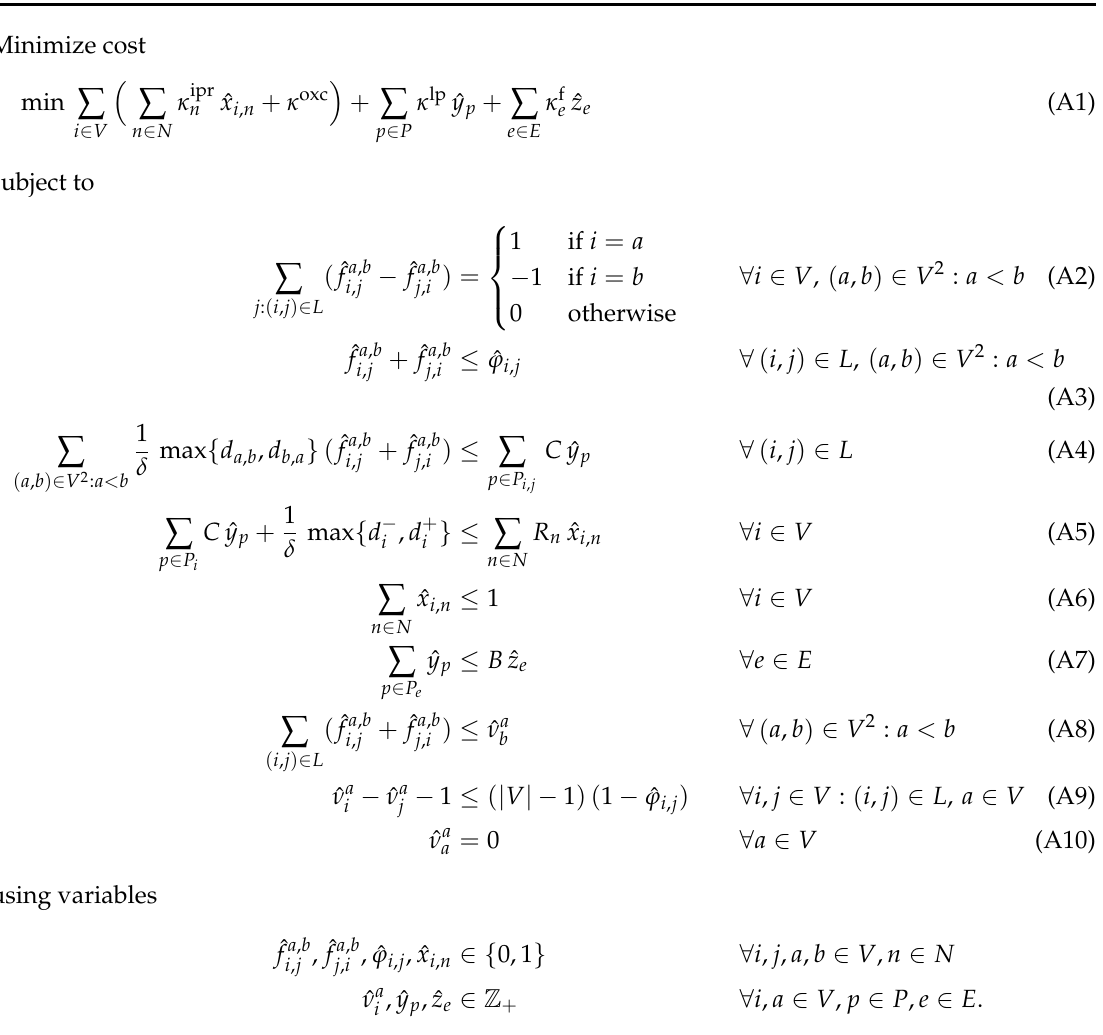
Table A1. MILP for SBN